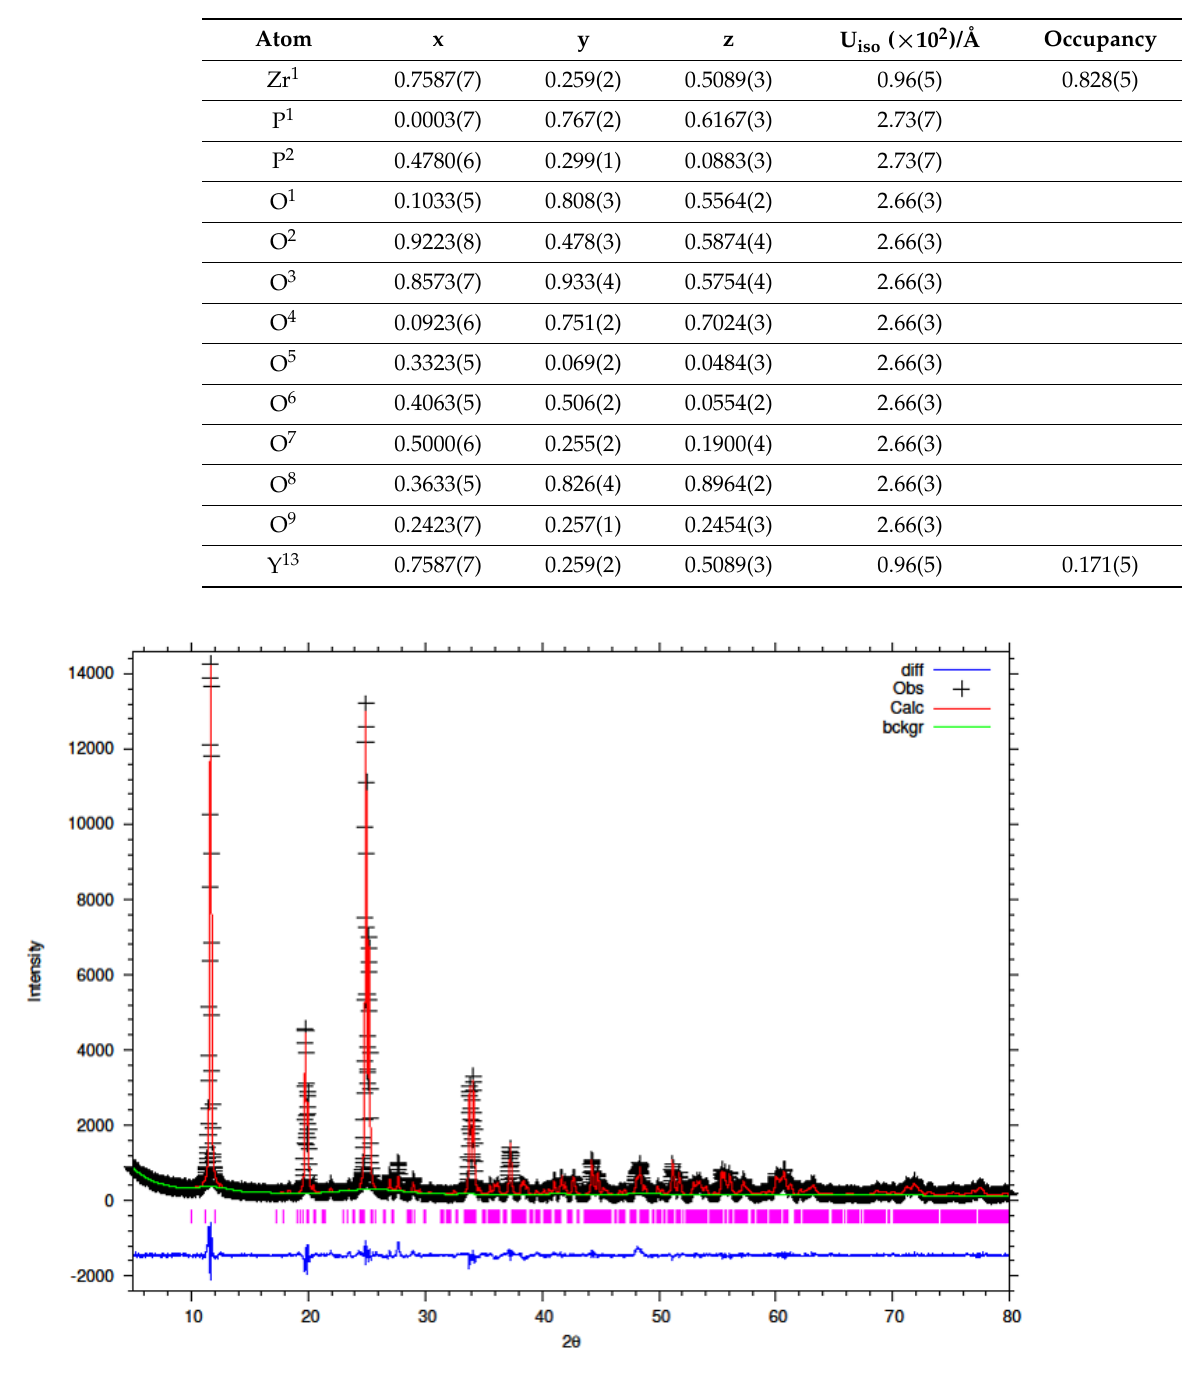
Figure 10. Final observed (cross), calculated (red line) and difference (blue bottom) Rietveld plots for conventionally refluxed 5% Y–ZrP.